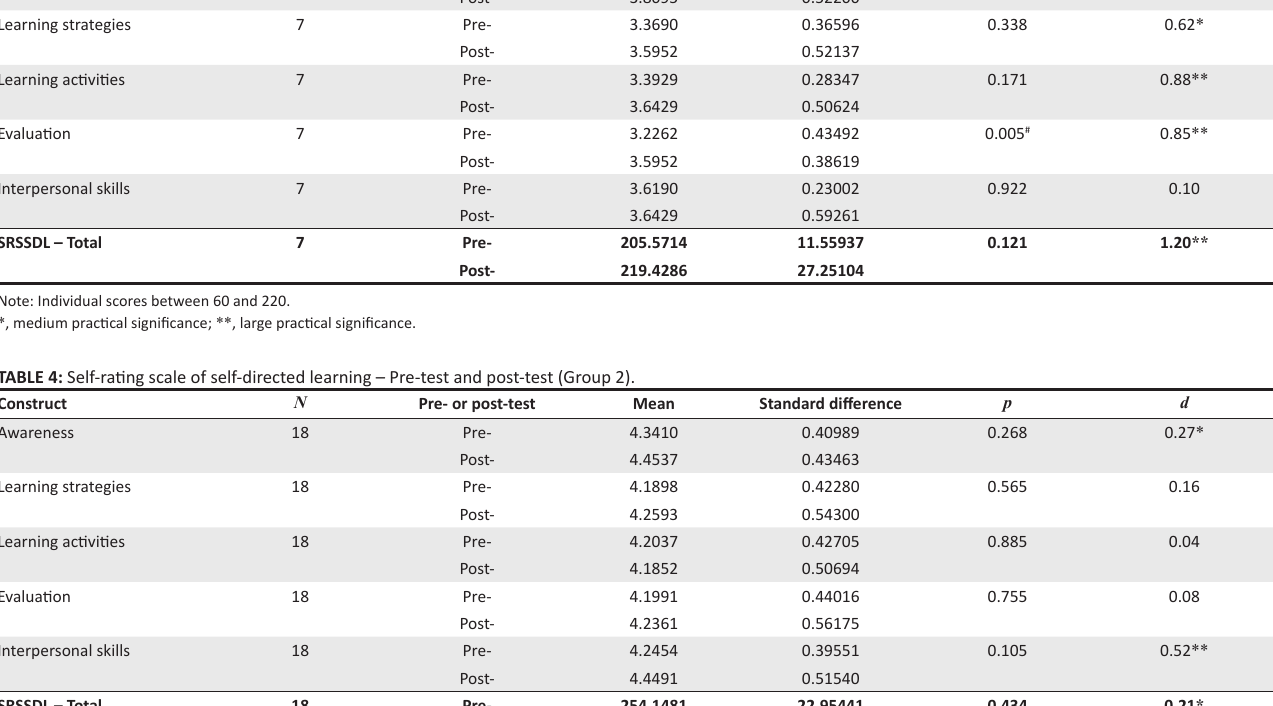
TABLE 3: Self-rating scale of self-directed learning – Pre-test and post-test (Group 1). Construct Awareness 7 Pre-